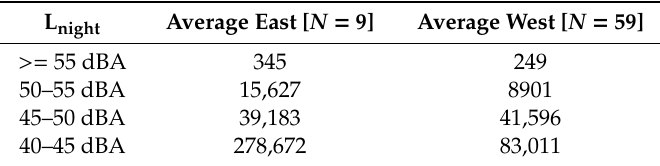
Table 1. Number of residents within each L night